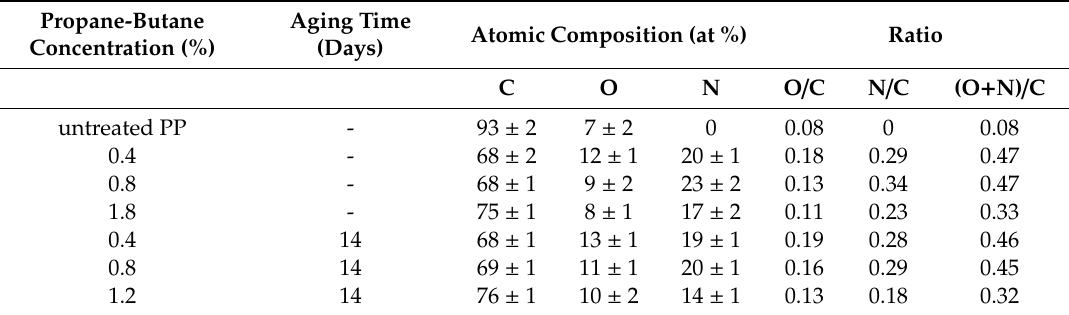
Table 1. Atomic concentrations (at %) and element ratios of untreated and plasma-modified surfaces for three di ff erent compositions of processing gas, i.e., 0.4, 0.8, and 1.2% of P-B in nitrogen. XPS spectra were measured immediately after plasma treatment and after 14 days of aging in ambient air. A treatment time of 15 seconds was kept in all cases. The percentages shown are the mean values of three